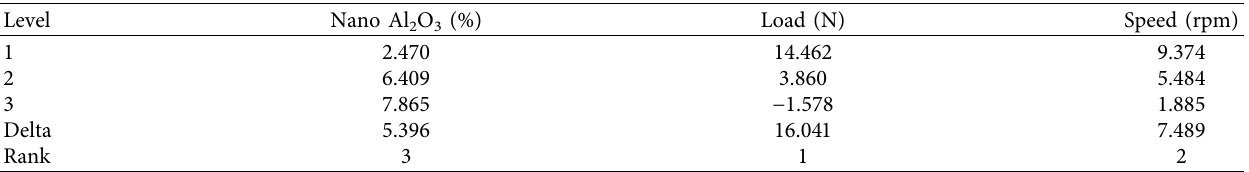
Figure 14: Wear loss of epoxy hybrid composites at 60 N load. Table 3: Response table for signal-to-noise ratios for wear loss.